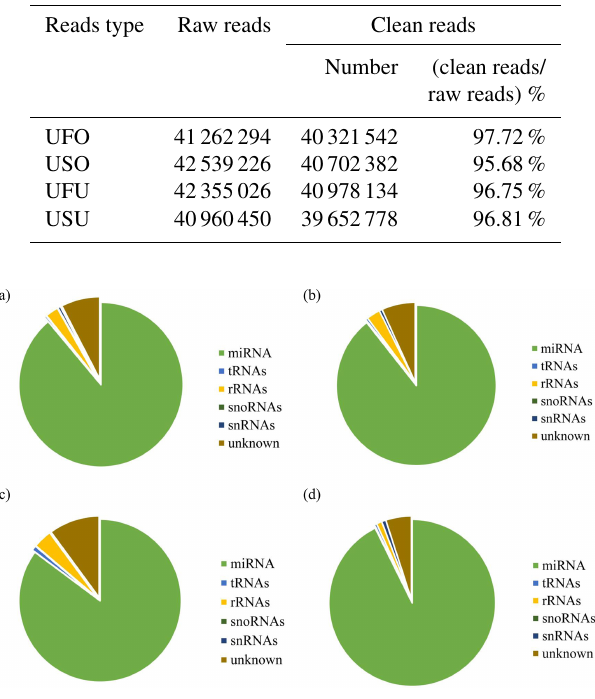
Figure 2. Statistics of the distribution characteristics of non-coding small RNAs between UF and US group. (a) UFO, (b) USO, (c) UFU, and (d) USU.